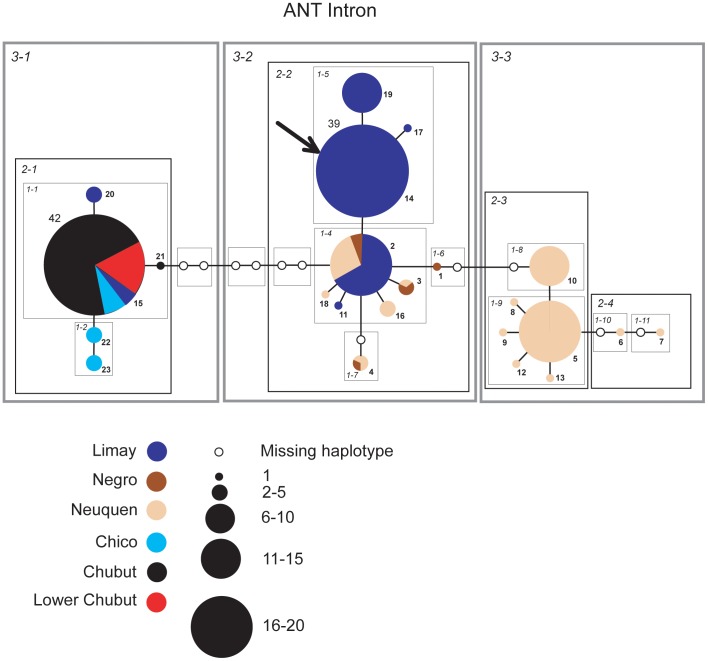
Haplotype networks with nested clade design for the nuclear ANT intron data.Haplotype circle size is proportional to its frequency. Each haplotypes is numbered. Haplotypes that exceed twenty individuals are labeled with the total number of individuals of that haplotype. Arrow indicates the root haplotype. Black empty circles represent extinct (or unsampled) haplotypes. Color codes indicate the six major rivers.